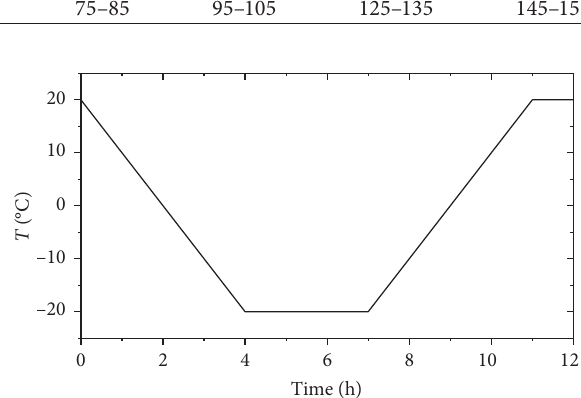
Figure 3: Salt-freezing cycle temperature system.